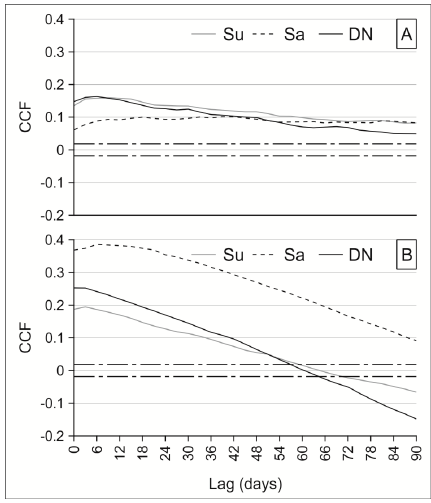
Figure 9. Cross-Correlations Function: rainfall–piezometric level ( A ); and river level–piezometric level ( B ). The dash-dotted lines indicate the significant thresholds.